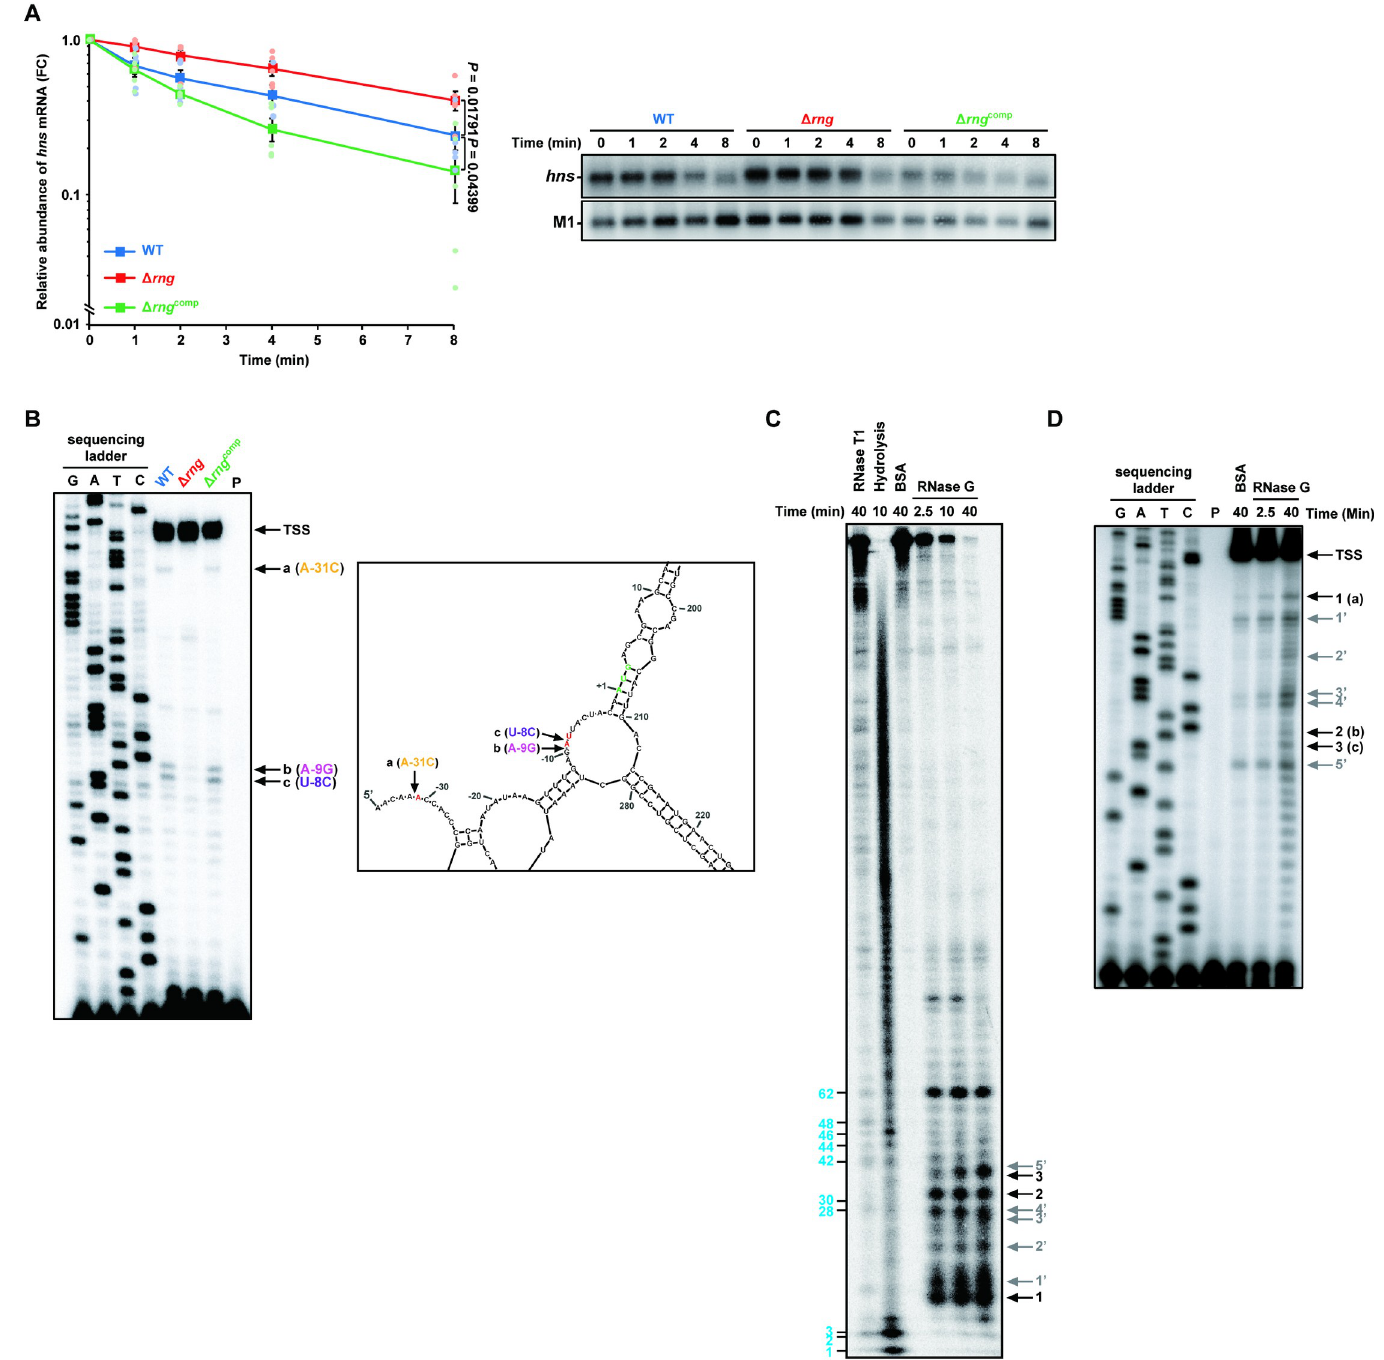
Fig 4. Down-regulation of hns mRNA abundance by RNase G. (A) Effect of cellular RNase G on hns mRNA decay in S . Typhimurium strains (WT, Δ rng , and Δ rng comp ) grown under anaerobic conditions, as measured by northern blot analysis. Data represent the mean ± s. e. m. of three independent experiments and presented on a semi- logarithmic plot. Statistically significant values from two-sided unpaired Student’s t -tests are indicated. (B) Primer extension analysis of hns mRNA 5 0 UTR in vivo . Left: Total RNA samples isolated from the S . Typhimurium cultures used in (A) were analyzed. Sequencing ladders were synthesized with the same primer used in cDNA synthesis and PCR DNA encompassing the hns gene as a template. Right: The secondary structure of the 5 0 UTR of hns mRNA deduced from the M-Fold program. Arrows indicate RNase G cleavage sites. The start codon is indicated by bold, green characters. TSS; transcription start site. (C) In vitro cleavage of hns mRNA. RNase T1 cleavage products are indicated by blue bold characters. Black arrows indicate the cleavage sites identified in (B) (1, 2, and 3). (D) Primer extension analysis of the in vitro -cleaved hns mRNA products purified from (C). Black arrows indicate the cleavage sites identified in (B) and (C) (1 = a, 2 = b, and 3 = c). For (C) and (D) , grey arrows indicate (1 0 - 5 0 ) nonspecific RNase G cleavage sites.